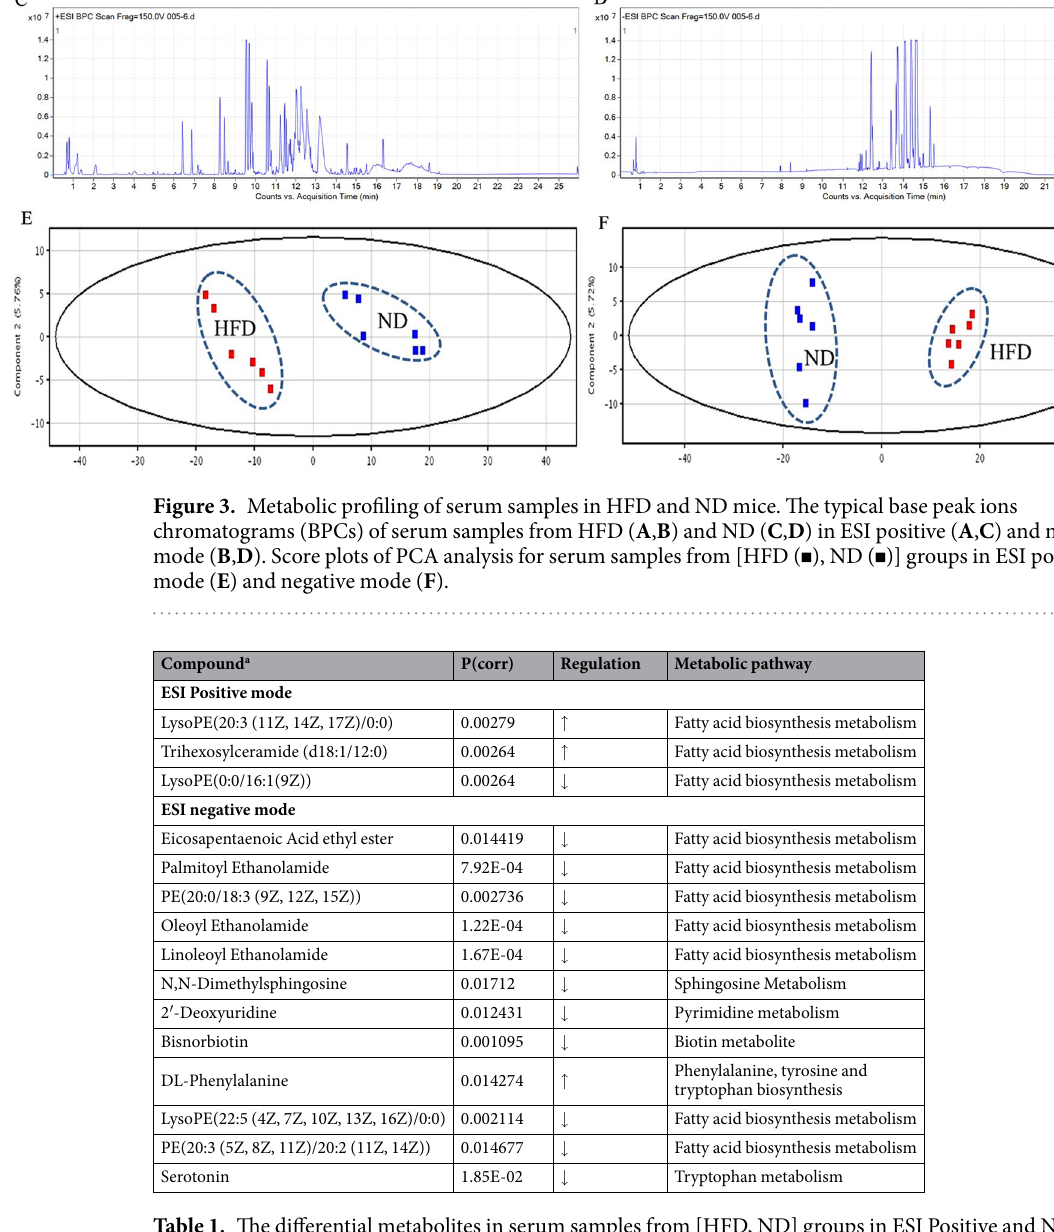
is shown in Fig. 2, HFD mice displayed typical depression symptoms, including reducted spontaneous activities and despair behaviors. After BZ and SMV intervention, the despair behaviors induced by HFD improved, but not spontaneous activity, which suggested antidepressant effects by the two drugs. As an important indicator of peripheral circulation that can reflect the real-time changes in various life activities accurately, serum has become a hot research topic in metabolomics studies 36 . An LC MS-based serum